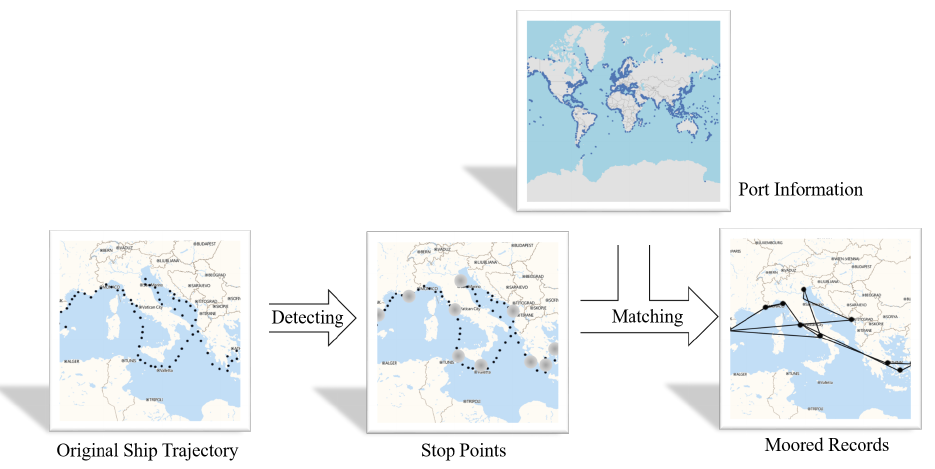
Figure 1. The demonstration of trajectory preprocess. The inputs include ship trajectories and port information. After the stop points detection and port matching, the output are ship moored